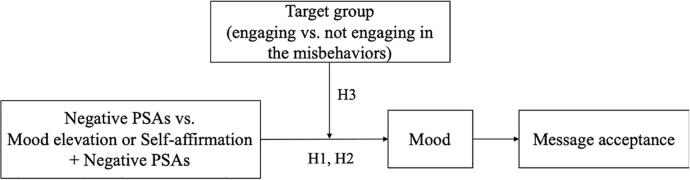
Conceptual model.